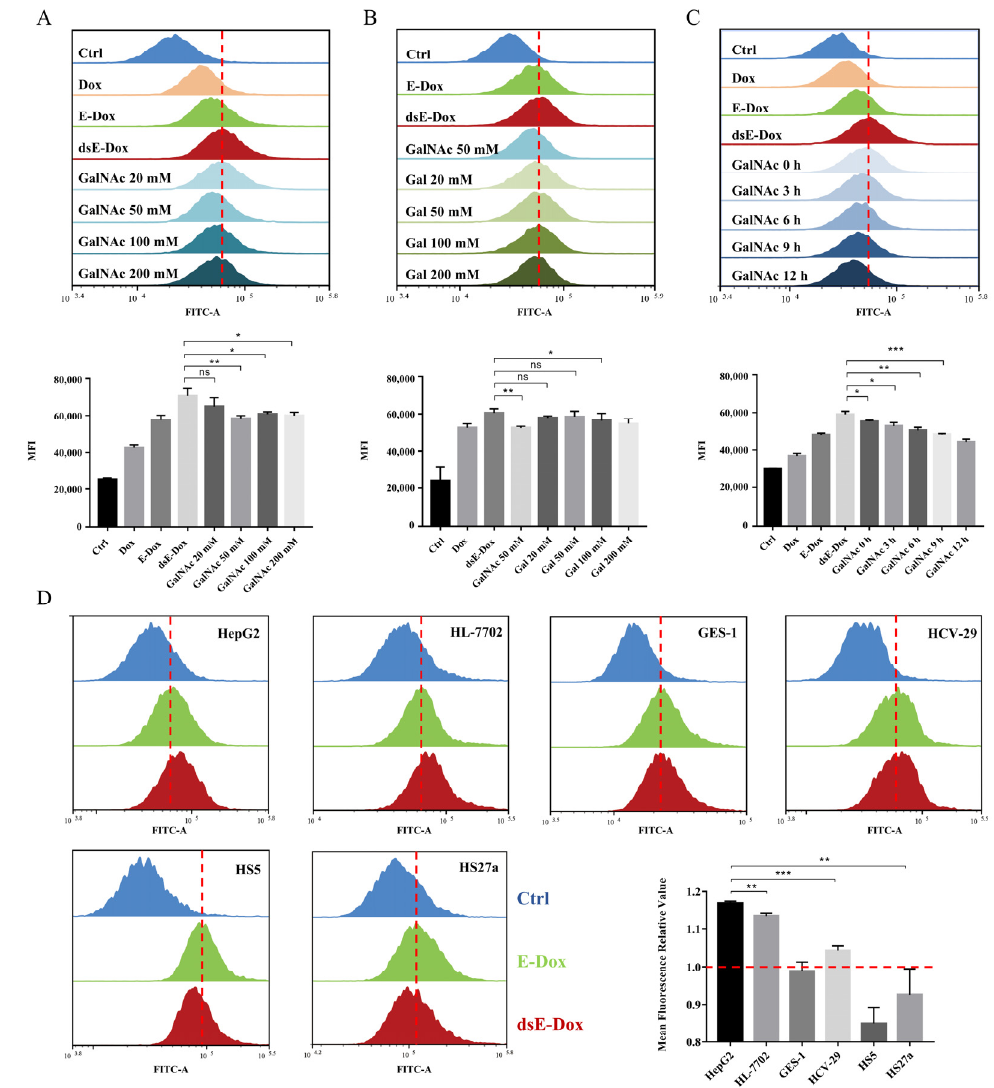
Figure 4. The targeting capability of MSC-EVs in vitro . ( A , B ) HepG2 cells were pretreated with various concentrations of GalNAc or Gal for 4 h, and the cellular uptake of dsE-Dox (loaded with 2 μ mol/L Dox) was detected by flow cytometry. ( C ) HepG2 cells were pretreated with 50 mM GalNAc for 0, 3, 6, 9, 12 h, and the cellular uptake of dsE-Dox (loaded with 2 μ mol/L Dox) was detected by flow cytometry. ( D ) The uptake of dsE-Dox (loaded with 2 μ mol/L Dox) by HepG2, HL-7702, CES-1, HCV-29, HS5, and HS27a cells were assayed by flow cytometry. The mean fluorescence relative value refers to the MFI ratio of dsE-Dox and E-Dox. The data were presented as the mean values ± SD. * p < 0.05, ** p < 0.01, *** p < 0.001.